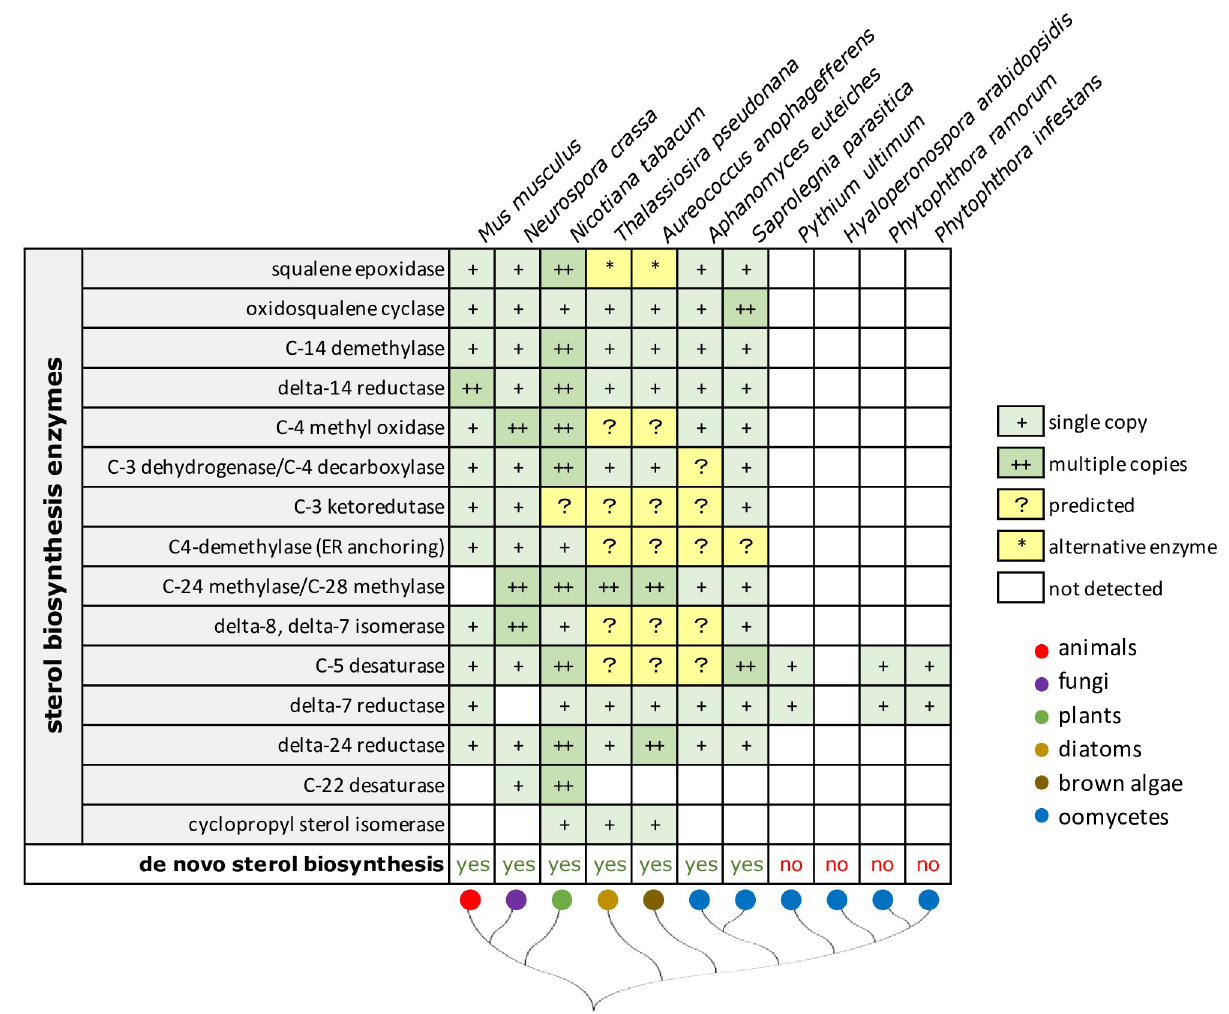
Fig 1. Sterol-auxotrophic oomycetes lack most canonical sterol biosynthesis enzymes. The sequential order of enzymes in the sterol biosynthesis pathway (left) and presence of the encoding genes in representative species from different eukaryotic lineages (in green). The simplified tree (bottom) shows the Stramenopiles in the right branch. It is anticipated that organisms showing de novo sterol biosynthesis have the complete set of enzymes. Most sterol autotrophs indeed have one (+) or multiple (++) copies of the encoding genes. However, not all genes that are predicted to be present have been detected (?). Possibly, there are alternative enzymes that take over, as is the case for squalene oxidase in some diatoms and brown algae ( � ). T AU : PleasecheckandconfirmifthesymbolusedinthesentenceThesterolauxotrophslackall ::: hasbeencapturedcorrectly : he sterol auxotrophs lack all or nearly all genes ( ▯ ). Data are from literature or obtained by mining databases.